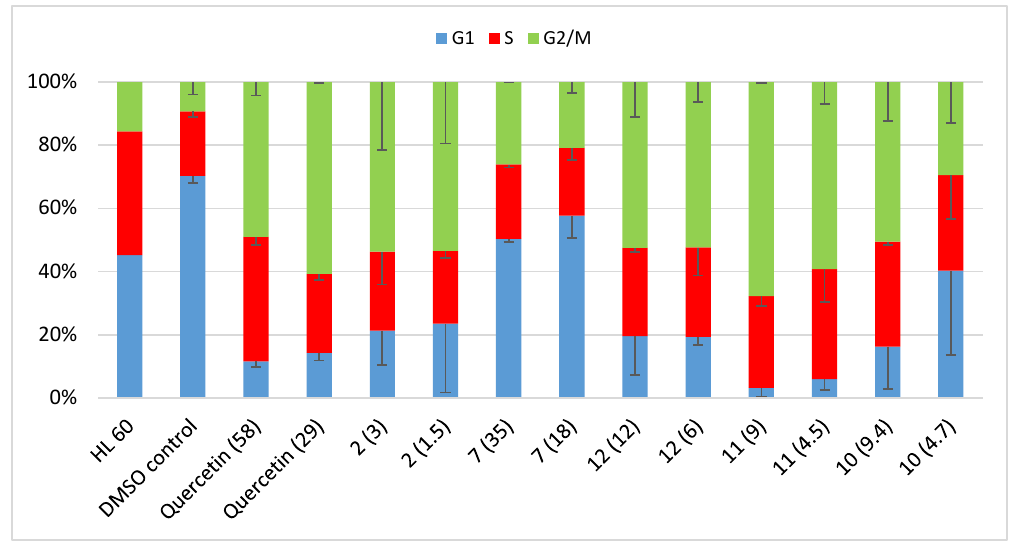
Figure 8. The effect of the test compounds and quercetin on the cell cycle in HL-60 cells. Cell cycle distribution of HL-60 cells after treatment with the test compounds. The concentrations of the compounds (in µM) are given in the parenthesis and correspond to 1x IC 50 and 0.5 × IC 50 (µM). 1% DMSO was used as the vehicle control. Bars represent mean values from two independent experiments .